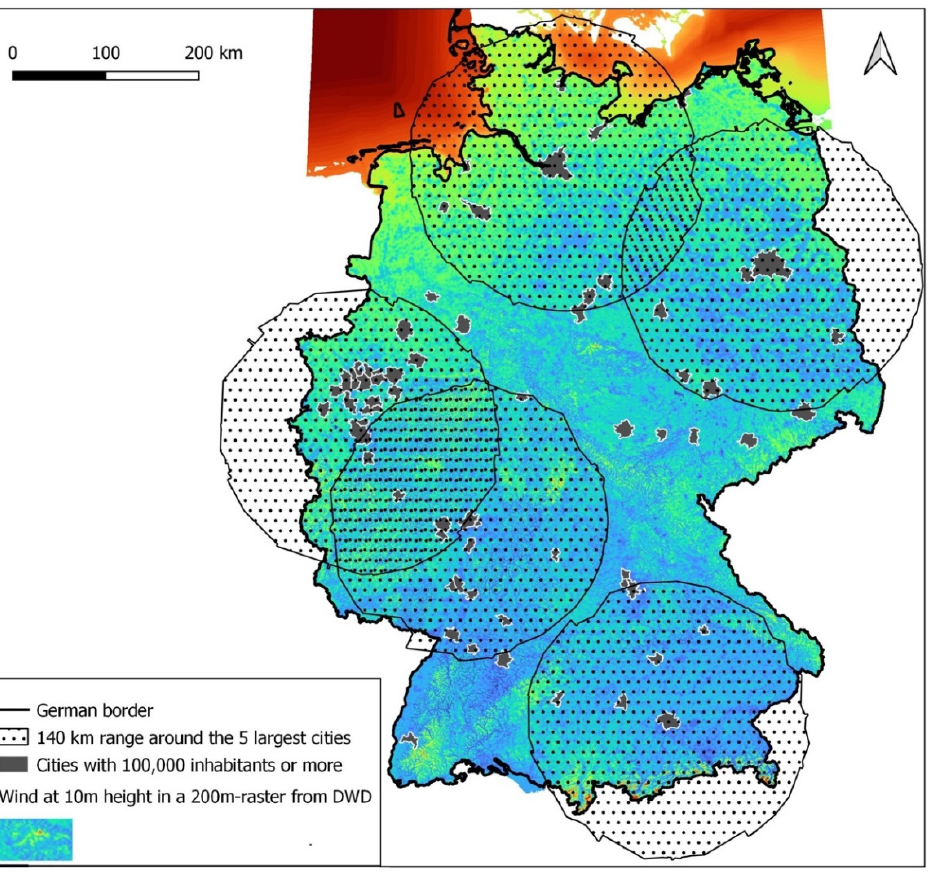
Figure 8. Wind speeds averages in Germany at 10 m above ground.